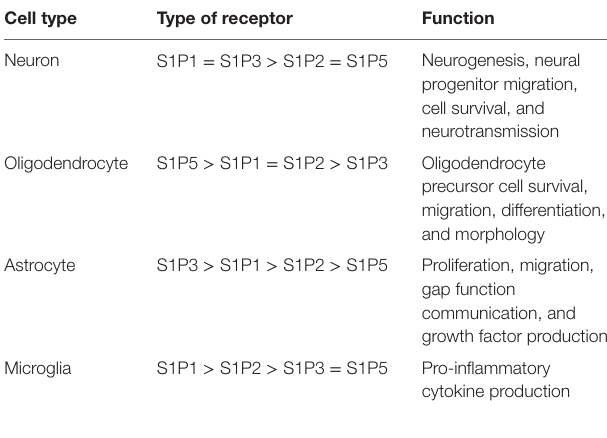
taBLe 1 | distribution and function of s1p receptors in the Cns (28,